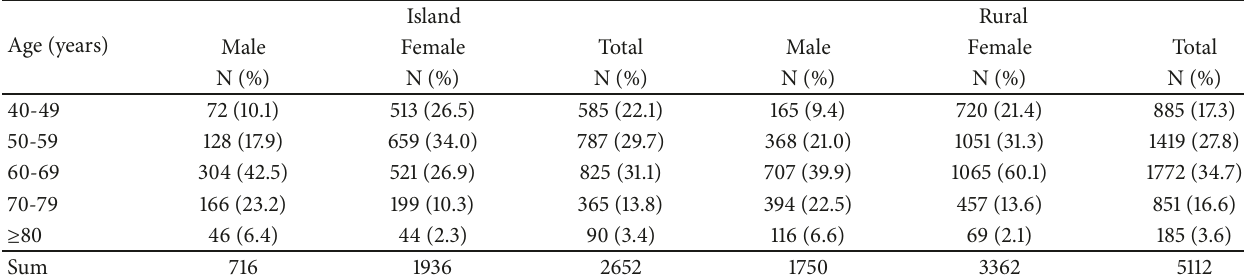
Table 1: The age and sex distribution in residents living in the island and rural areas. Island Age (years)